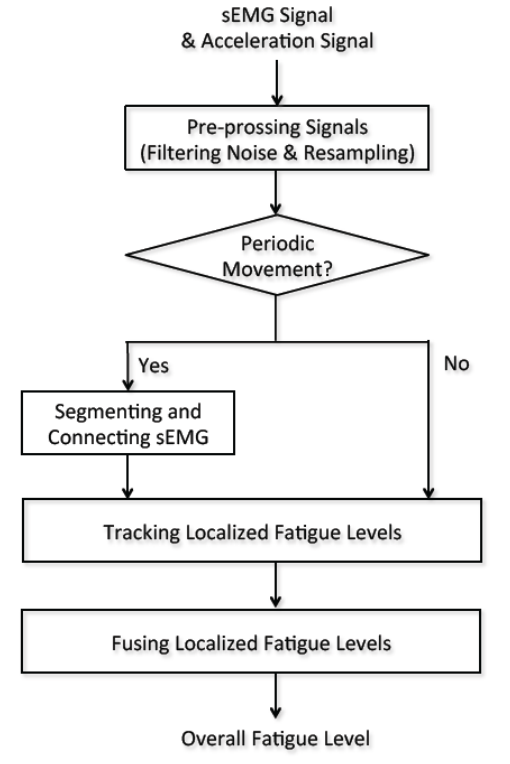
Figure 2. Scheme diagram of the system. Periodic movement is recognized by analyzing the acceleration signal pattern. Non-active sEMG signals are cut off by segmenting the original sEMG signal. The processed sEMG signal is used for tracking localized muscular fatigue levels. The overall fatigue level is obtained by fusing the localized fatigue